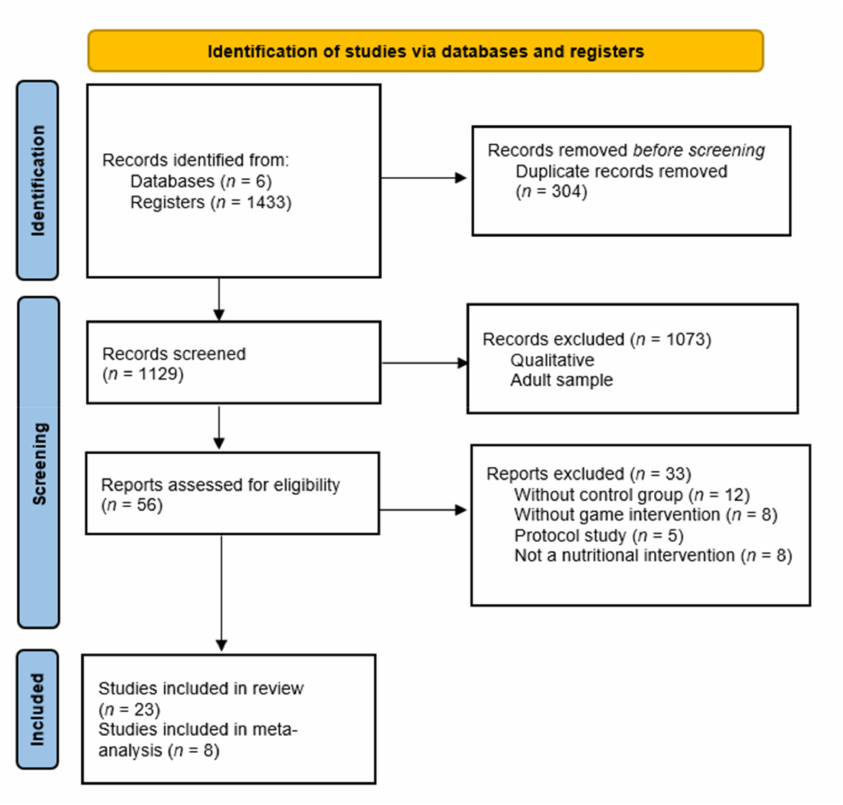
Figure 1. Flow diagram of the publication search